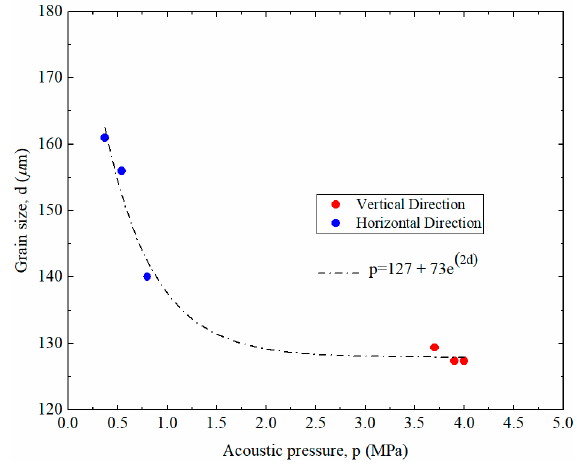
Figure 10. E ff ect of acoustic pressure versus grain Figure 10. Effect of acoustic pressure versus grain size.